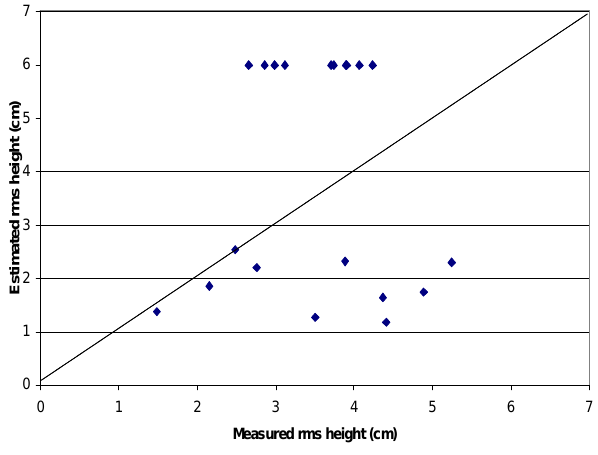
Fig. 7. Scatter plot of rms height measured and estimated by OM.